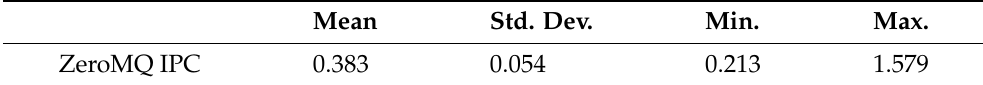
Table 5. ZeroMQ interprocess communication delay in milliseconds. A sample size of 10,000 requests of 500 bytes each. Mean Std. Dev. Min.